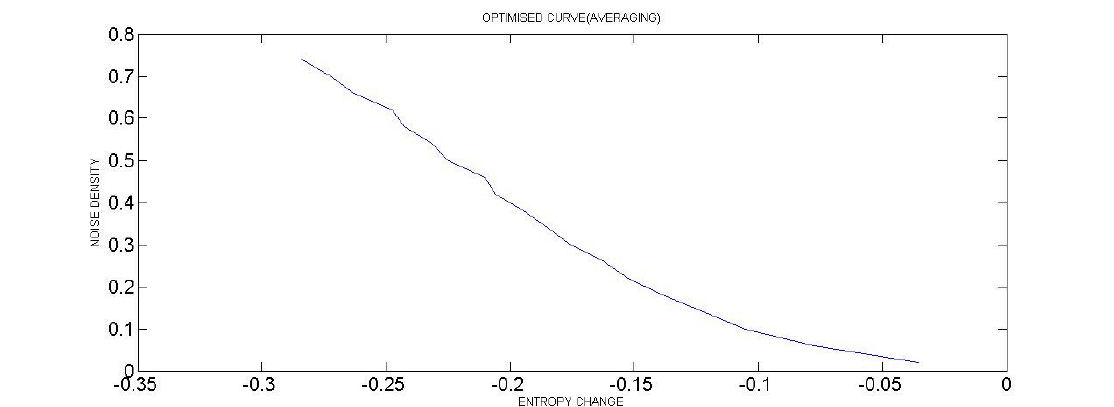
Figure 3. Generalization of data